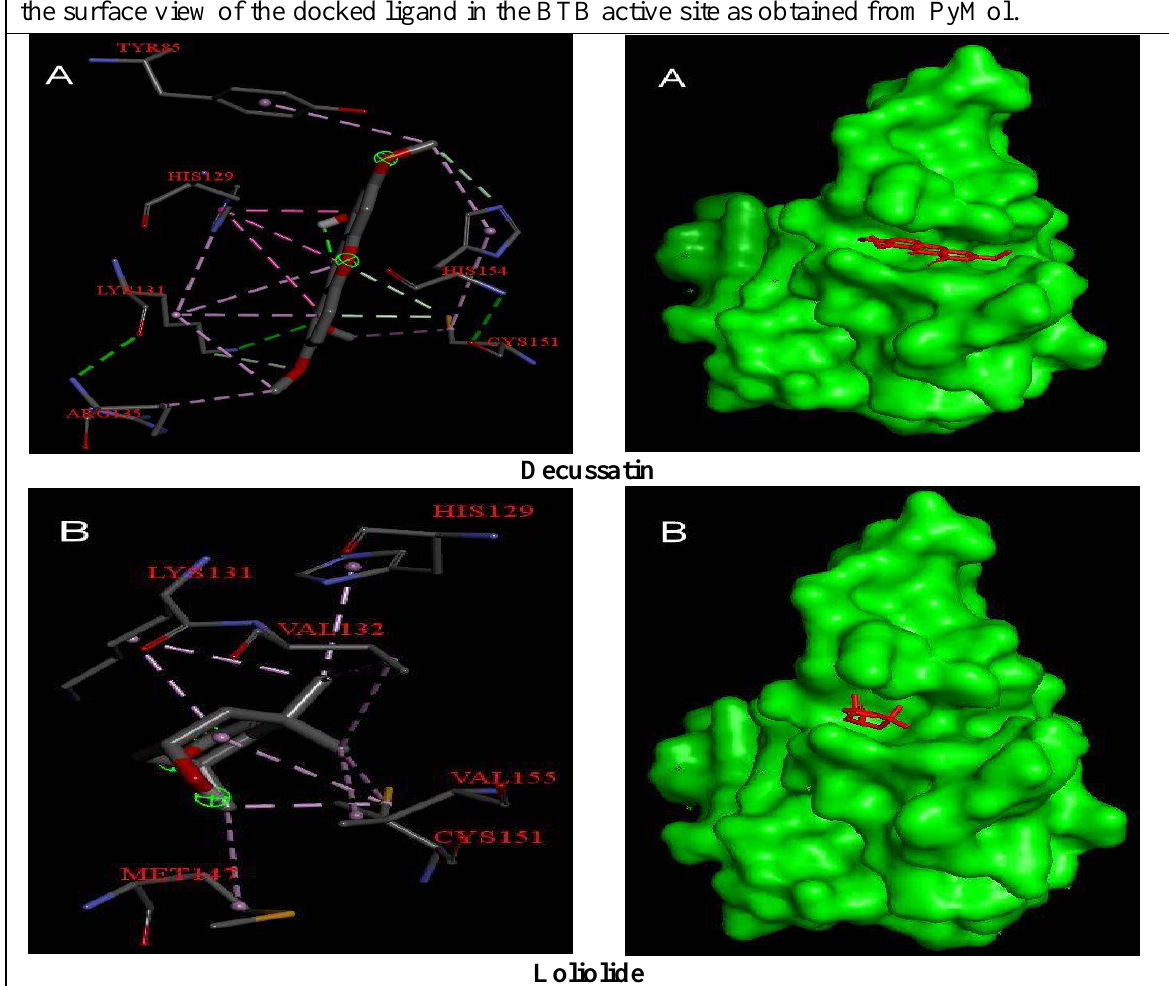
Figure S5: The three-dimensional illustrations of the interaction analysis of the individual ligands with the BTB domain of the Keap1 protein as obtained from the Discovery studio and the surface view of the docked ligand in the BTB active site as obtained from